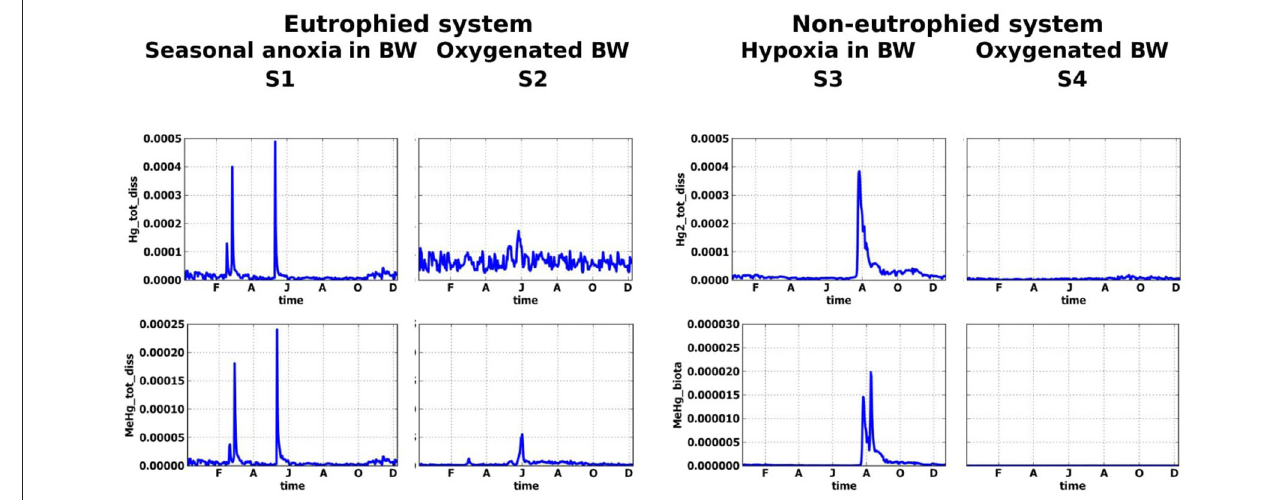
FIGURE 6 | Simulated seasonal dynamic of dissolved Hg(II) and MeHg ( µ M) at sediment-water interface for different scenarios, S1–S4.